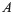
Graphs of PE, PF and PT for A of Example 1, where nT = nR = l = 2, where SNR is a function of Es.